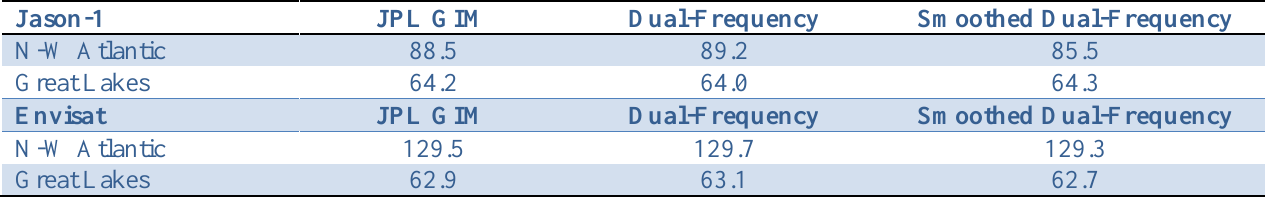
Table 4. Standard deviations (in mm) of the crossover height differences for Jason-1 and Envisat during the years 2003–2004, using JPL GIM, non-smoothed dual-frequency range measurements and smoothed dual-frequency range measurements for the correction of the ionospheric refraction. The N-W Atlantic Ocean region (52°–40°W, 41°–49°N) is shown for